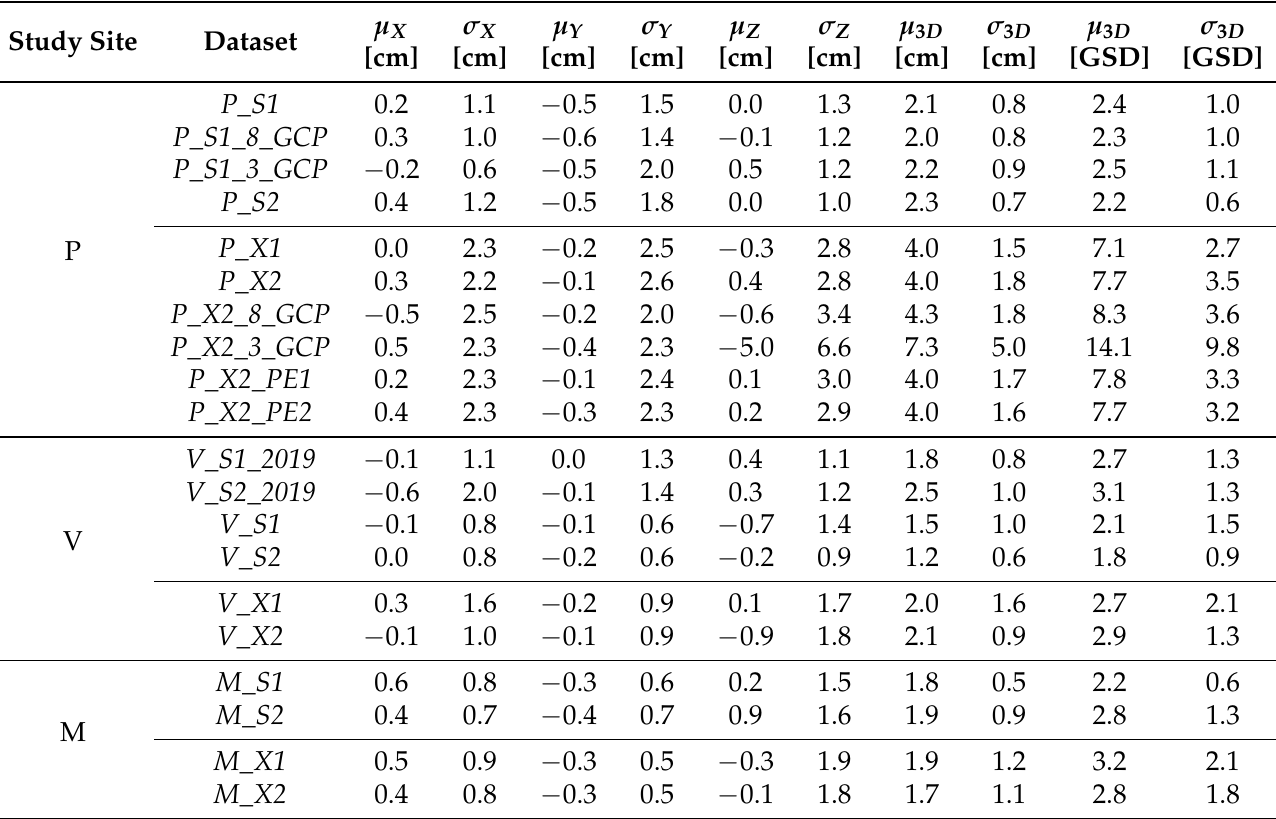
Table 4. Residuals on Check Points (in cm). Mean value µ and standard deviation σ are reported for each component ( X , Y , Z ) and for the total 3D error. For the latter, mean and standard deviation are reported also as a function of the average GSD.